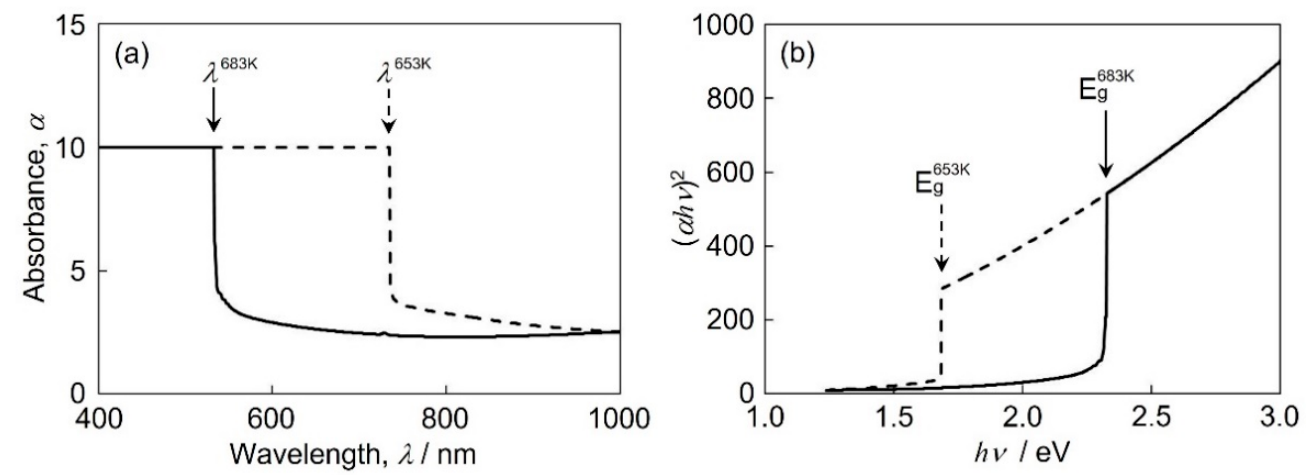
Figure 5. Effect of the annealing temperature on the UV-VIS absorption spectra ( a ) and the ( α h ν ) 2 vs. h ν plot for determining the energy band gap ( b ) of electrodeposited ZnTe thin films onto ITO glass substrates. The ZnTe thin films were annealed at 653 K and 683 K.